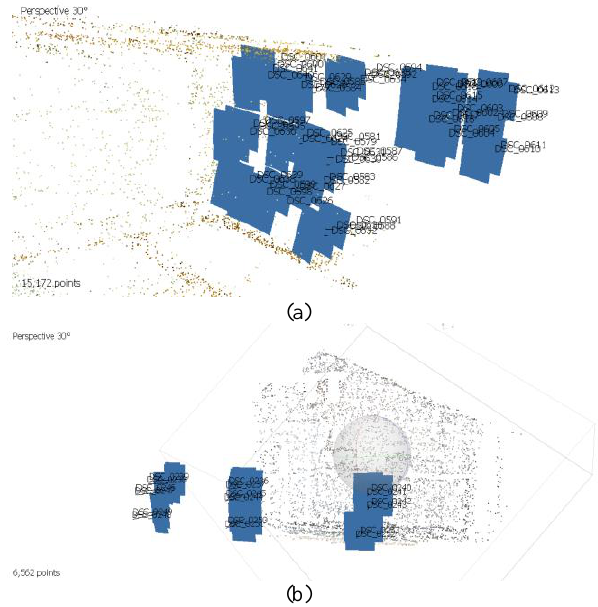
Figure 6. Camera configuration for (a) indoor camera calibration and (b) outdoor camera calibration Camera calibration parameters between indoor and outdoor observations are compared, and the best results are used for photogrammetric processing for deformation observations at a later stage. The best results can be seen from the standard deviation values generated from each camera